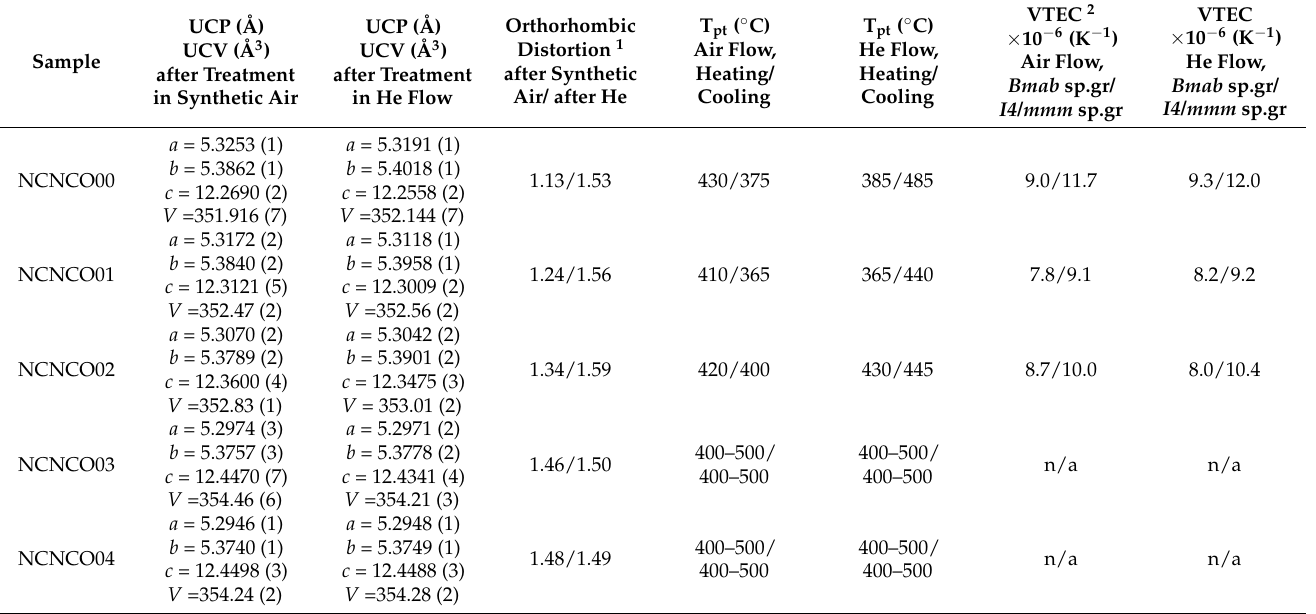
Table 4. Results of the in-situ XRD study of the NCNCO00-NCNCO04 samples: unit cell parameters (UCP) and unit cell volume (UCV) (collected at room temperature), temperatures of the phase transition ( T pt ), and calculated values of the volumetric thermal expansion coefficient